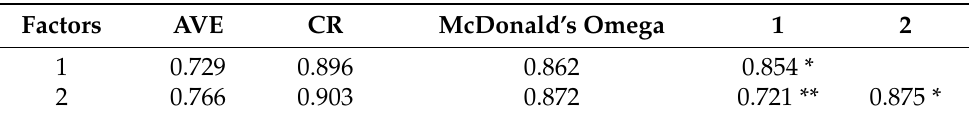
Table 3. Evidences of composite reliability, average variance extracted for the Attitudes Scale Towards Violence (EAV) items.